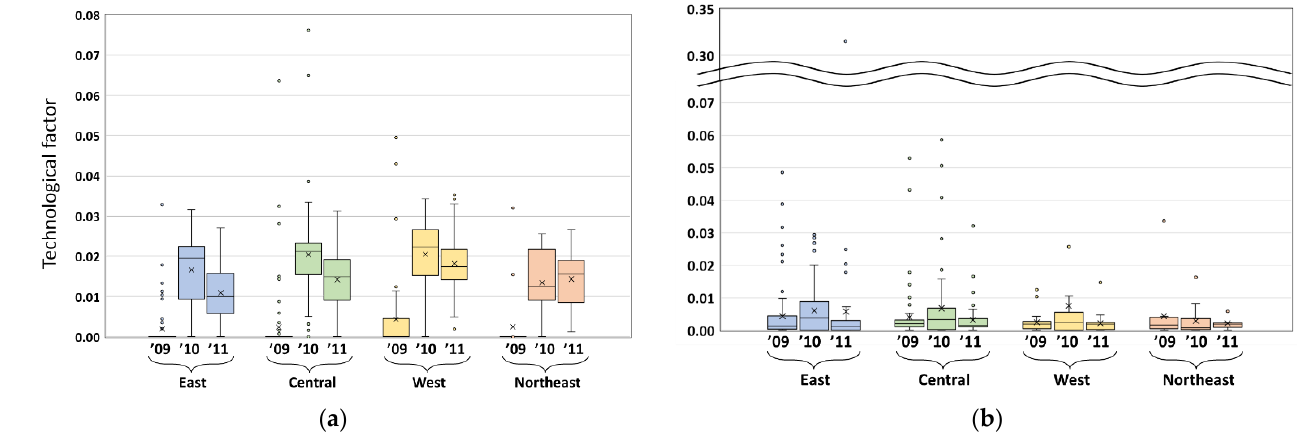
Figure 3. Boxplots of technological factor in ( a ) the SM group and ( b ) the LARGE group by year and region. ’09, ’10, and ’11 refer to the years 2009, 2010, and 2011, respectively. “×” and “°” stand for the average value and outliers, respectively.